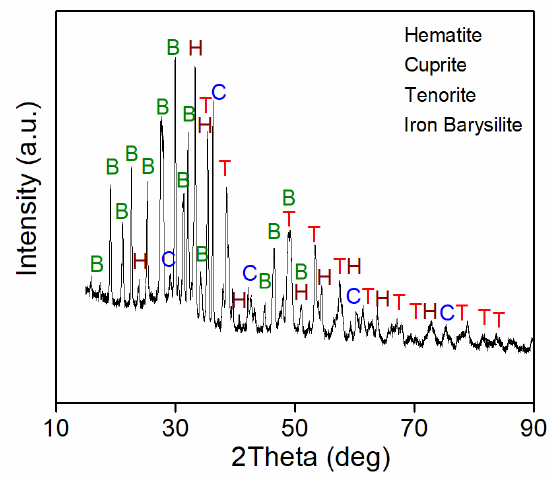
Figure A17. XRD result from the grisaille where lead white was used. Hematite (H), cuprite (C), tenorite (T), and iron barysilite (B) were identified.